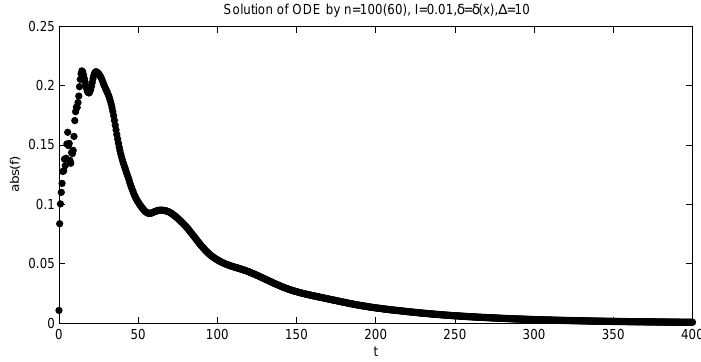
Figure 5. Solution | f ( t, 15) | by n = 100 , I = 0 . 01 , δ = δ ( x ) , ∆ = 10 . The finite-difference schemes (5.2), (5.4) are stable for σ ≥ 0 . 5 , but they are not sufficiently accurate. Using the matrix of derivatives on the uniform grid it is possi- ble to make calculations only for small n ( n ≤ 25) , otherwise the calculations are